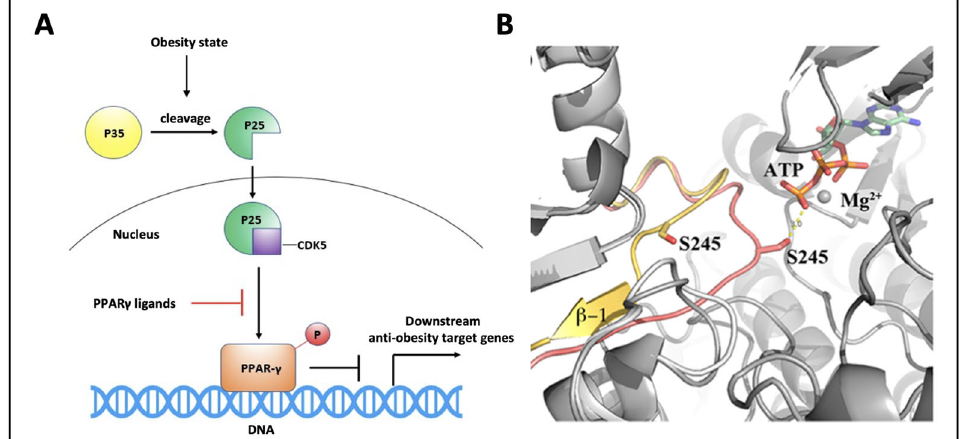
Figure 1. PPAR γ phosphorylation mechanism. ( A ) High-fat diet induces inflammation and cleavage of the p35 protein to p25, which activates CDK5 triggering PPAR γ phosphorylation on S245. Phospho-PPAR γ prevents the transcription of anti-obesity target genes; ( B ) Superposition of PPAR γ modeled during CDK5 phosphorylation (pink) and PPAR γ in its native form (yellow) showing the transitory unfolding of the outer β‐ sheet [31].